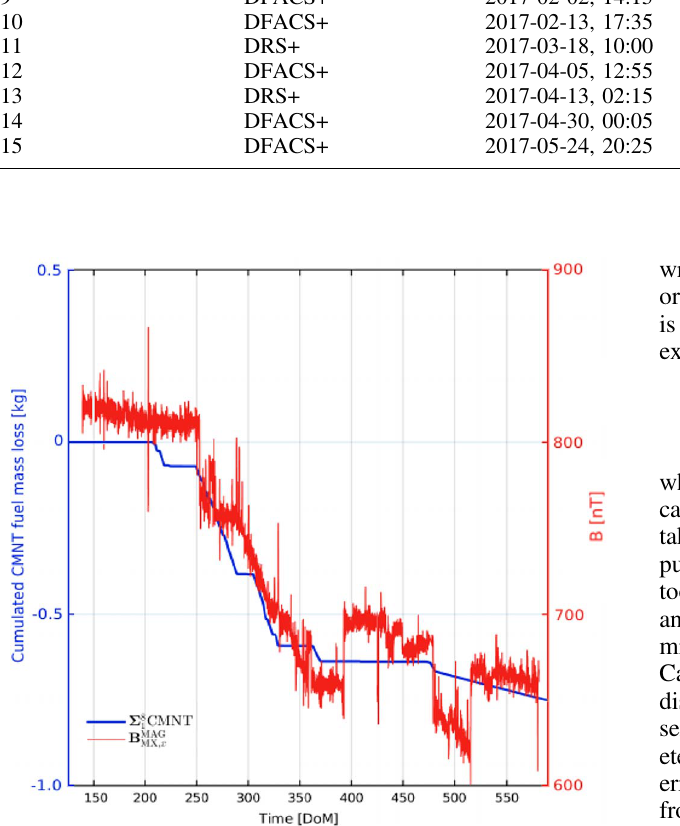
Figure 7. Total CMNT fuel mass ejected and onboard induction ½ t (cid:4) (in blue and red, respectively) magnetic fi eld time-series B MAG m recorded by the MX magnetometer along the LTP x